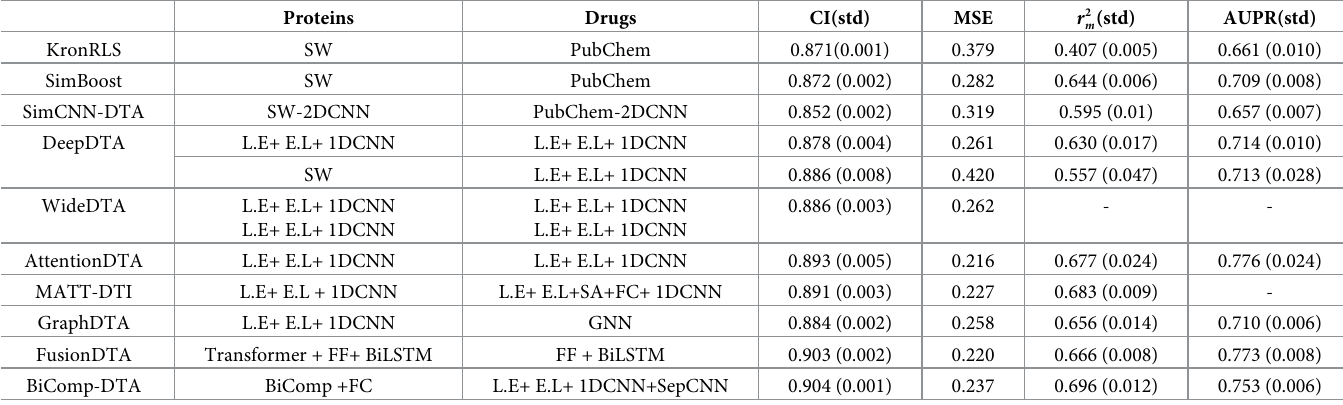
Table 1. The CI, MSE, r 2 and AUPR values for the BiComp-DTA compared to the alternative methods–Davis dataset. m Proteins